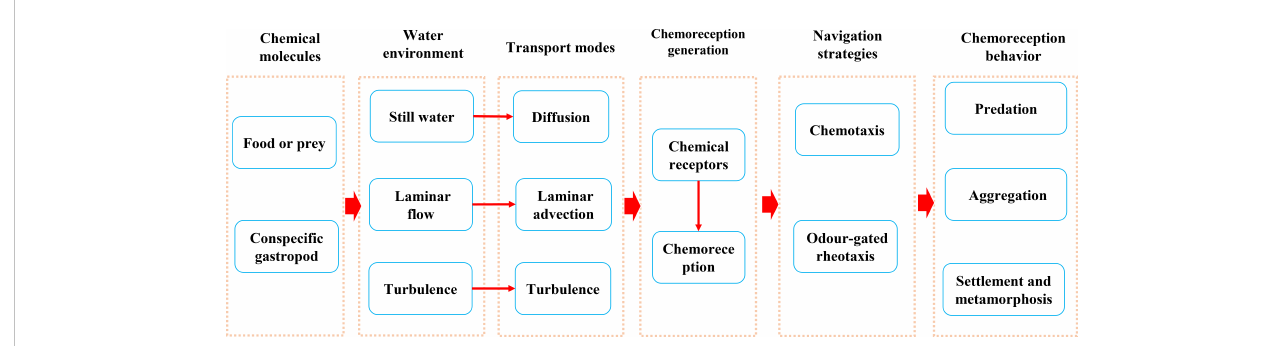
FIGURE 2 Chemoreception behaviors of gastropods and their perception and localization